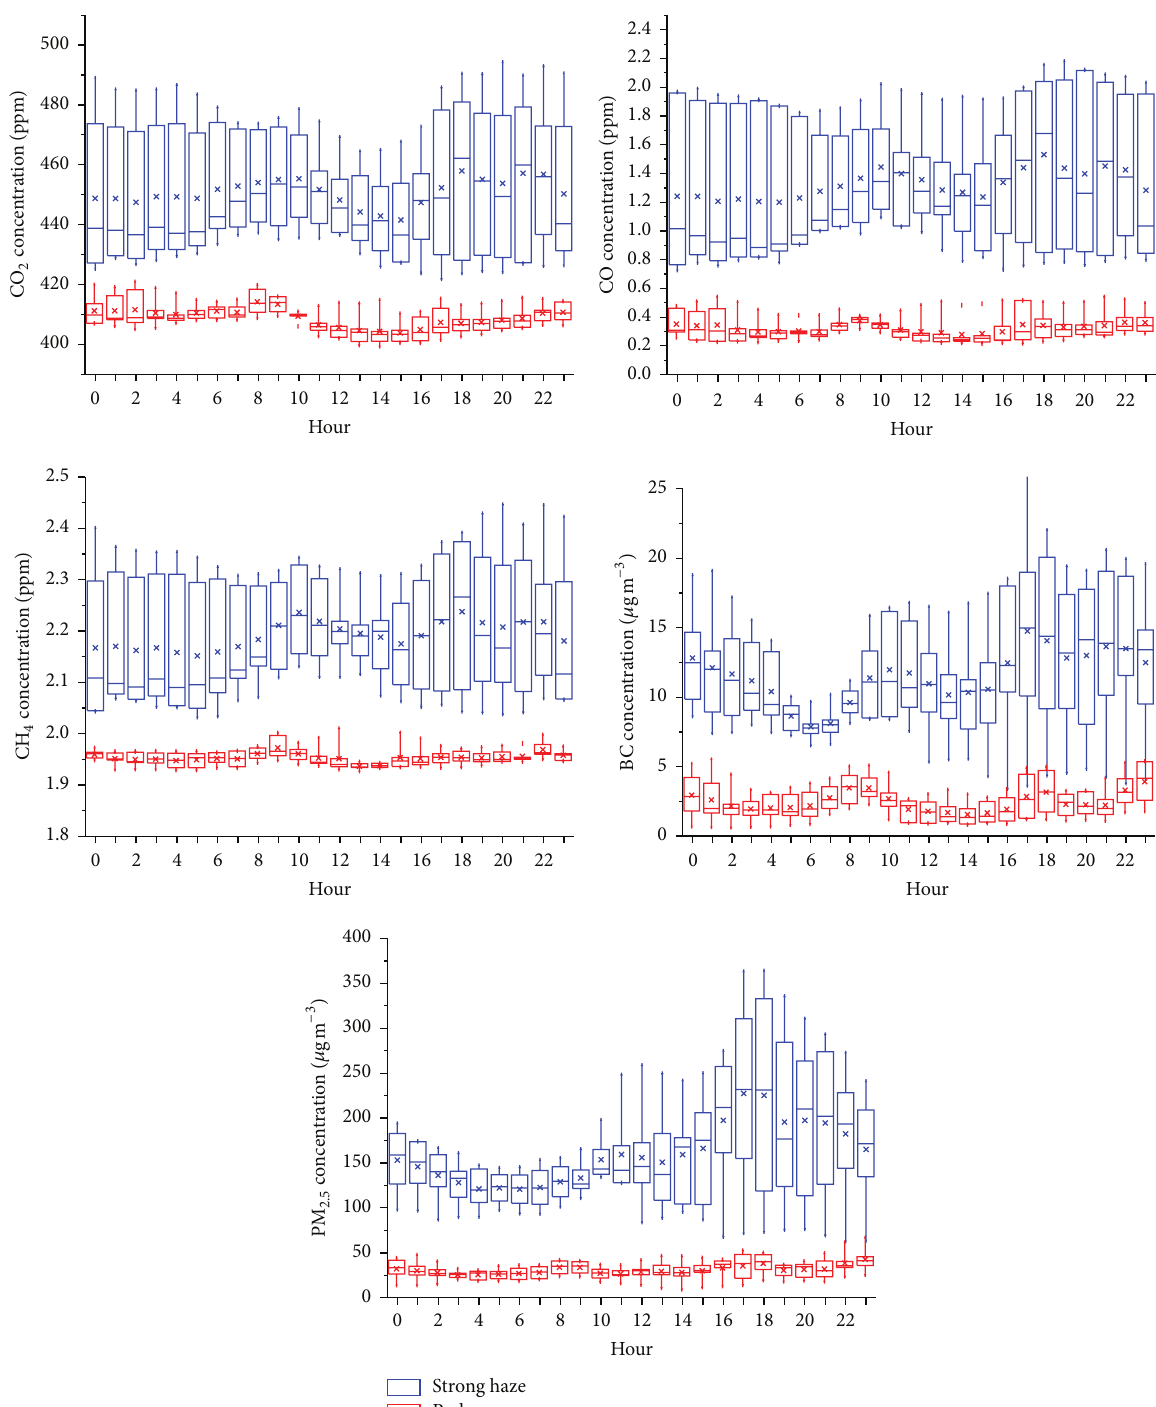
Figure 9: Diurnal concentration variations of CO 2 , CO, CH 4 , BC, and PM 2.5 at Lin’an regional background station.